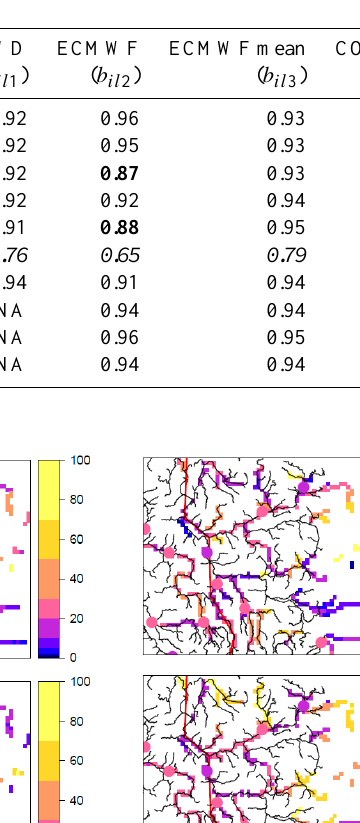
Table 1. Cross-validation r 2 -values for EMOS-parameters for different lead times. Bold numbers are below 0.9, italic numbers are below 0.8.